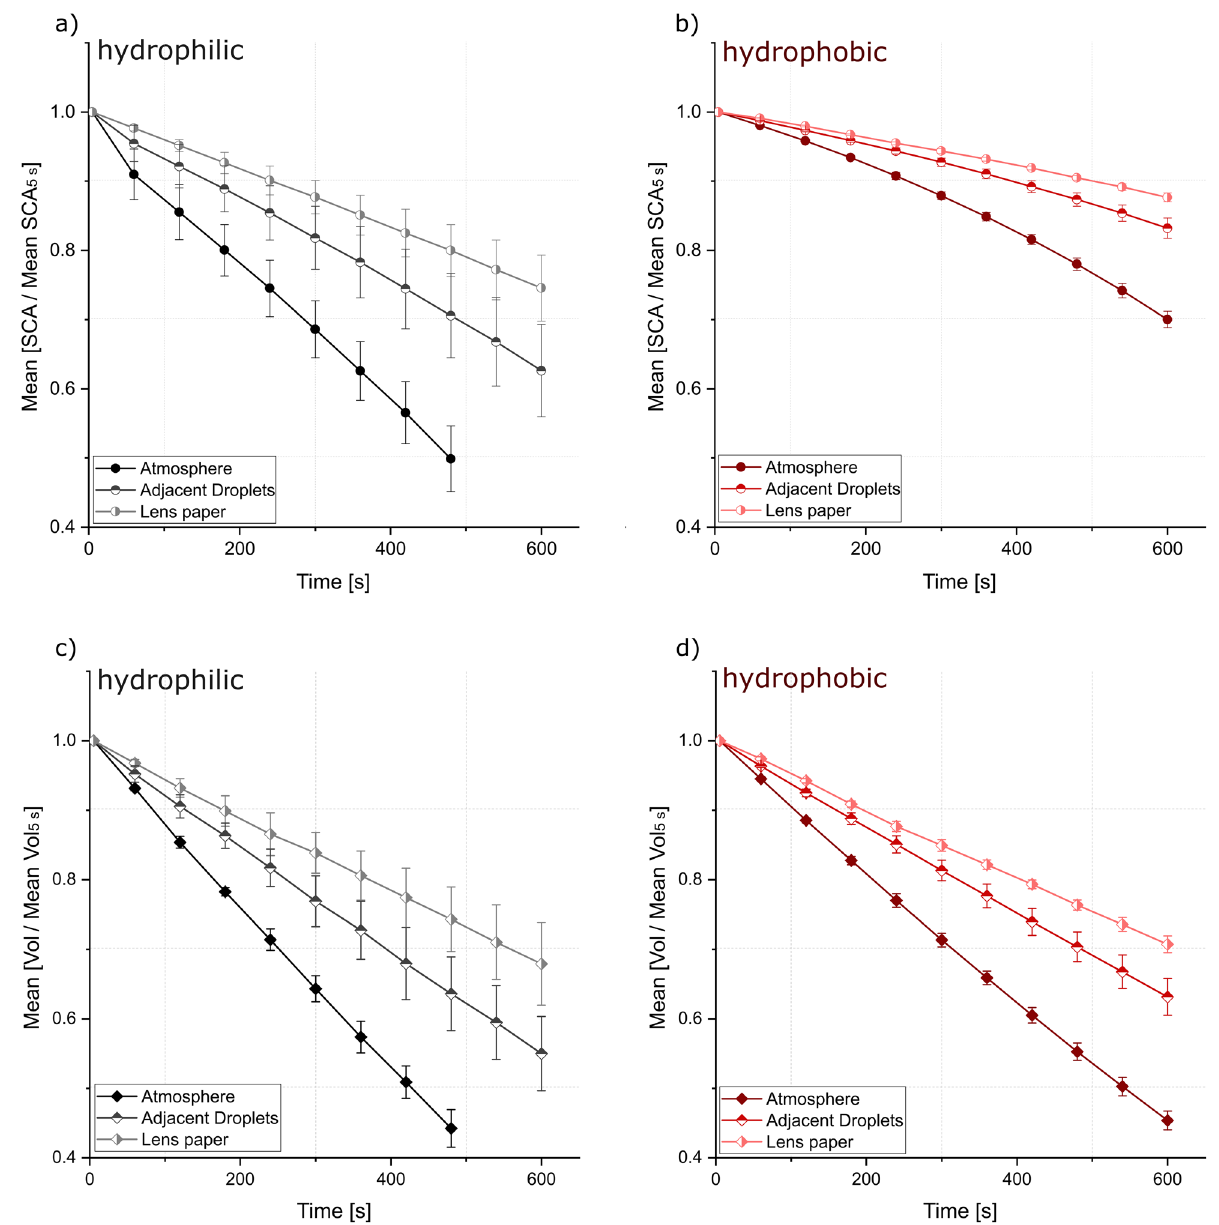
Figure 10. Change of the contact angle and volume for hydrophilic ( a,c ) and hydrophobic ( b,d ) copper surfaces through evaporation of 3 µl droplets under atmospheric conditions (Atmosphere), with adjacent droplets (Adjacent Droplets) and with wetted lens paper (Lens paper). Each experiment was repeated three times on different samples. Data for normalization is the contact angle/volume five seconds after droplet application. For better data visualization the normalized data for each of the three samples was averaged for every time step. Error bars show the standard